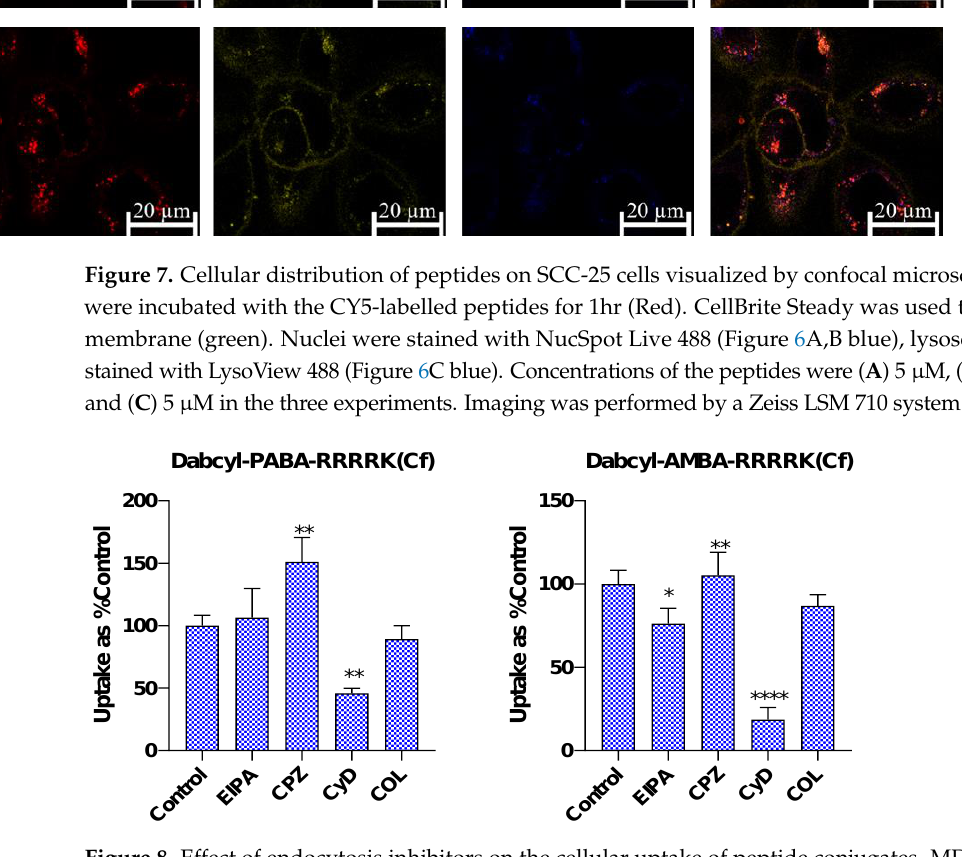
Figure 9. Effect of endocytosis inhibitors on the cellular uptake of peptide conjugates. MDA-MB- 231 cells were pretreated with NaN 3 (10 mM) and DOG (5 mM) for 30 min, the cells were then treated with the peptide conjugates (5 µM) for 90 min. Significant difference from control was meas- ured using Student’s t test (* p < 0.05 and ** p < 0.01). Upon the pretreatment with NaN 3 and DOG, the uptake was significantly lower. The internalization of Dabcyl-AMBA-RRRRK was reduced to a greater extent than Dabcyl- PABA-RRRRK. This experiment suggests the presence of a nonendocytic route for the peptides, as they are still taken up after the inhibition of endocytosis.